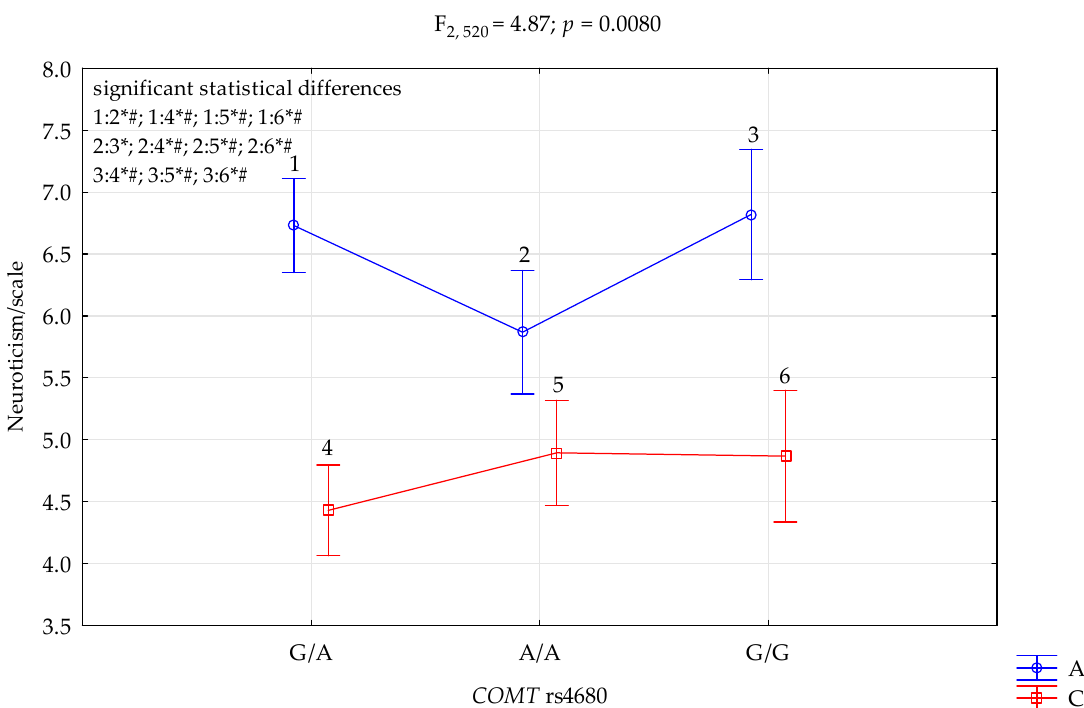
Figure 2. Interaction between patients addicted to stimulants (AS)/Control (C) and COMT rs4680 and STAI state/scale. *—significant result, # Bonferroni correction was used, and the p -value was reduced to 0.0083 ( p = 0.05/6 (number of statistical tests conducted)).